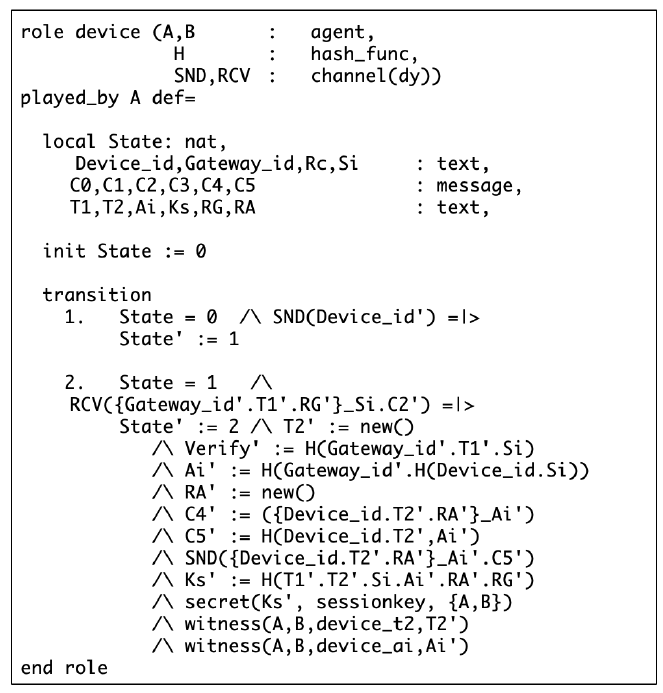
Figure 9. Specification of the SD role for high security risk.